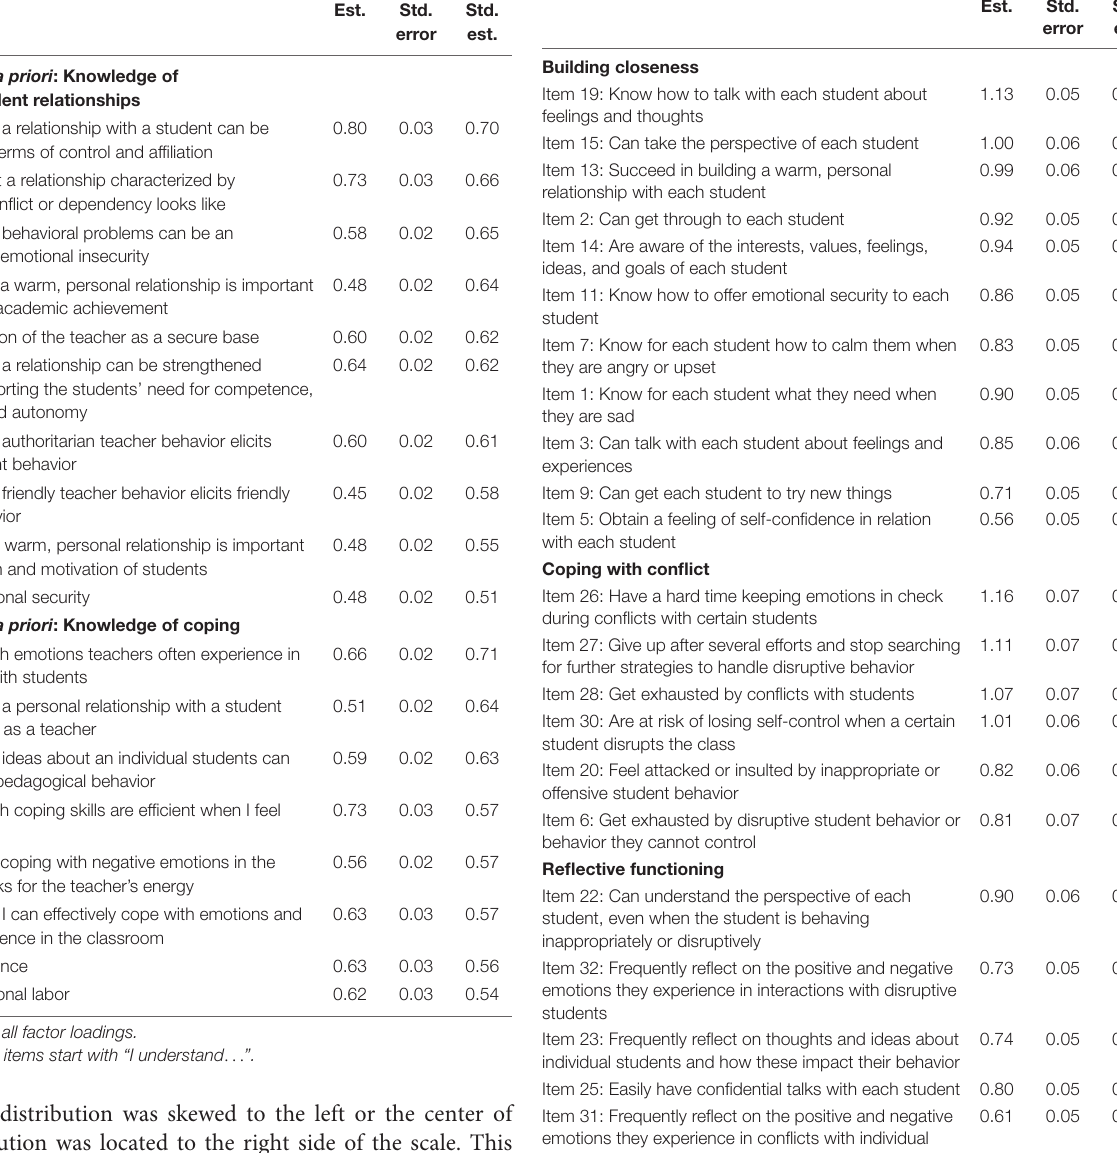
Est. Std. Std. error est. 1.13 0.05